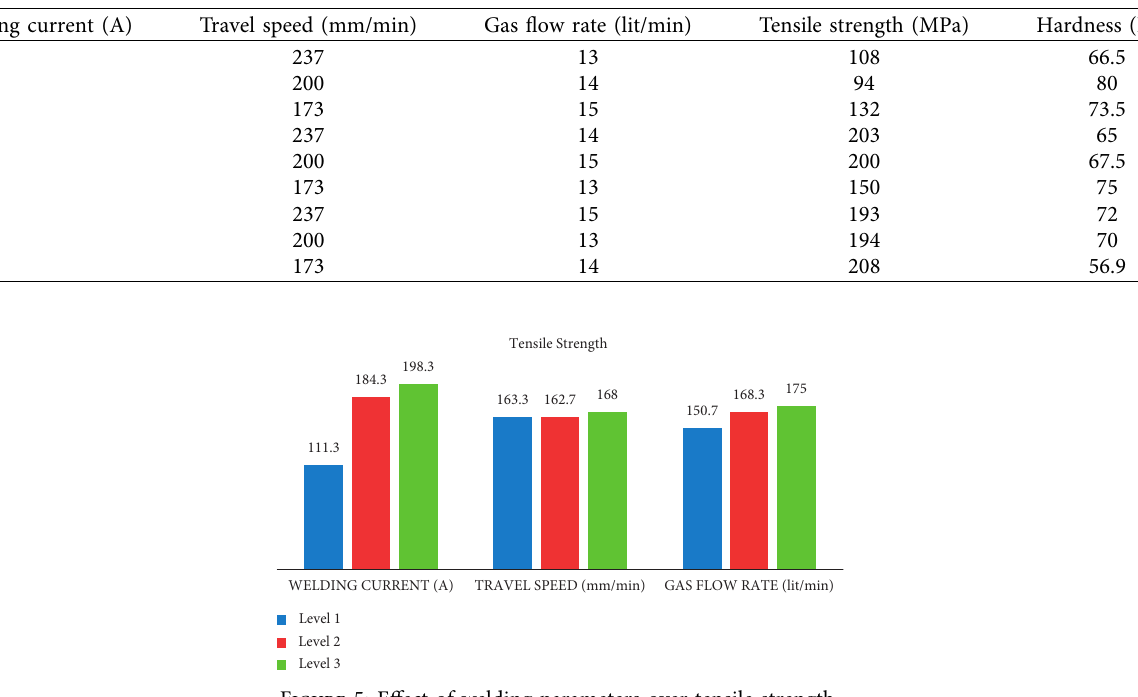
Figure 4: Parameters under consideration. Table 2: Experimental results.